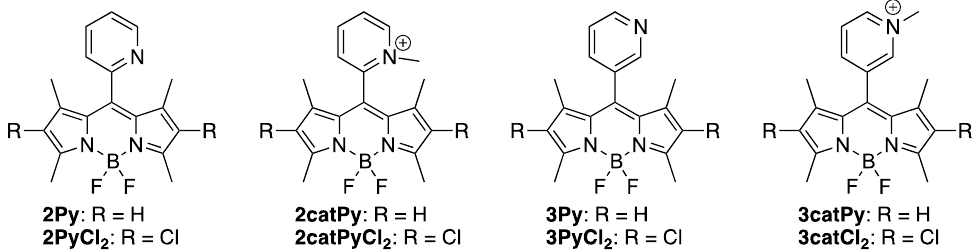
Figure 3. Structure of series of BODIPYs synthesized in this